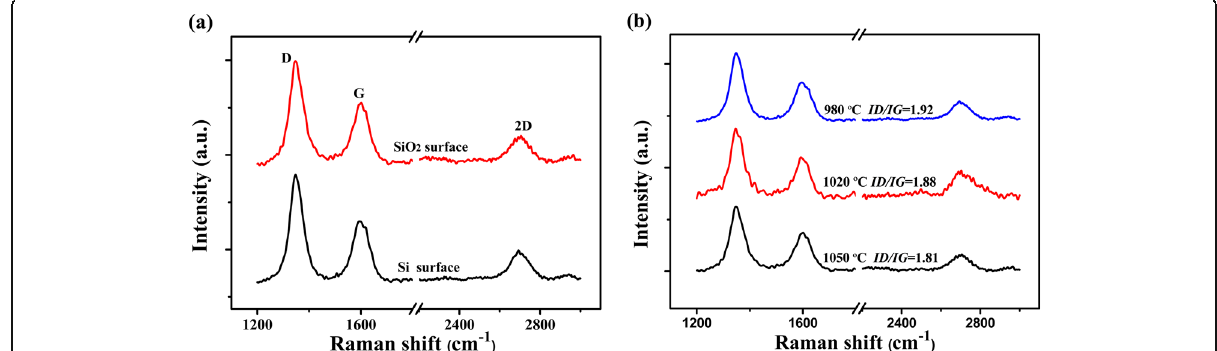
Fig. 6 a Raman spectra of graphene dendrites grown on both Si and SiO 2 surface of SiO 2 /Si substrates. b Raman spectra of grpahene dendrites grown on Si surface from 980 °C to 1050